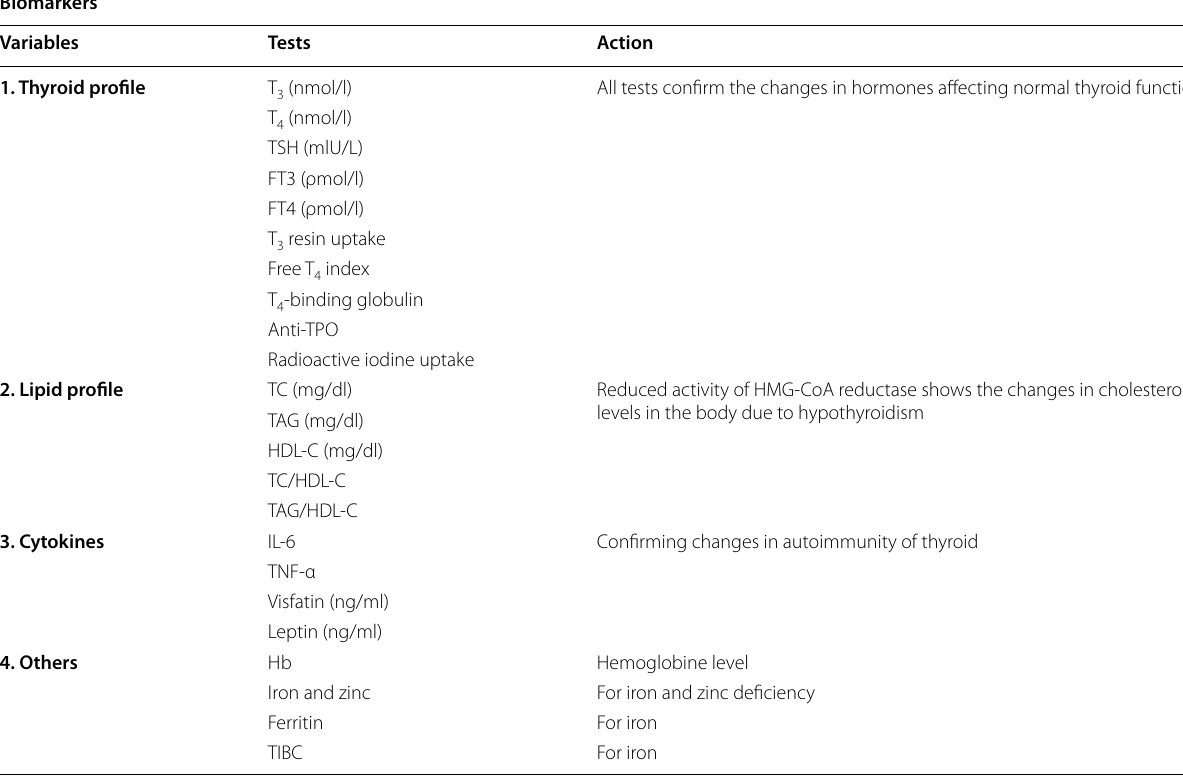
Table 1 Summary of different biomarkers